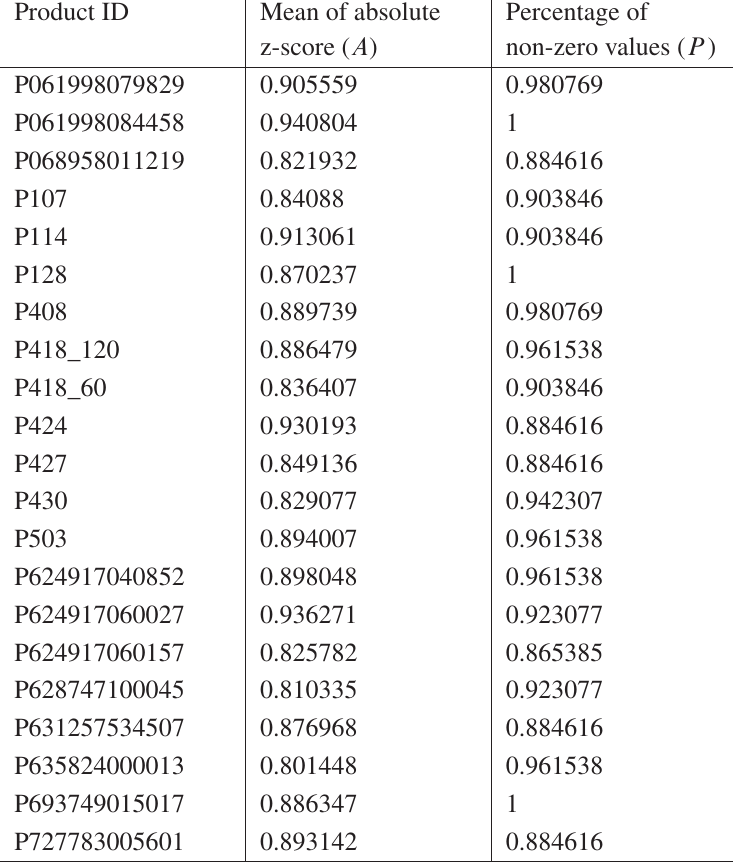
Table 7. A sample of time series clustering data